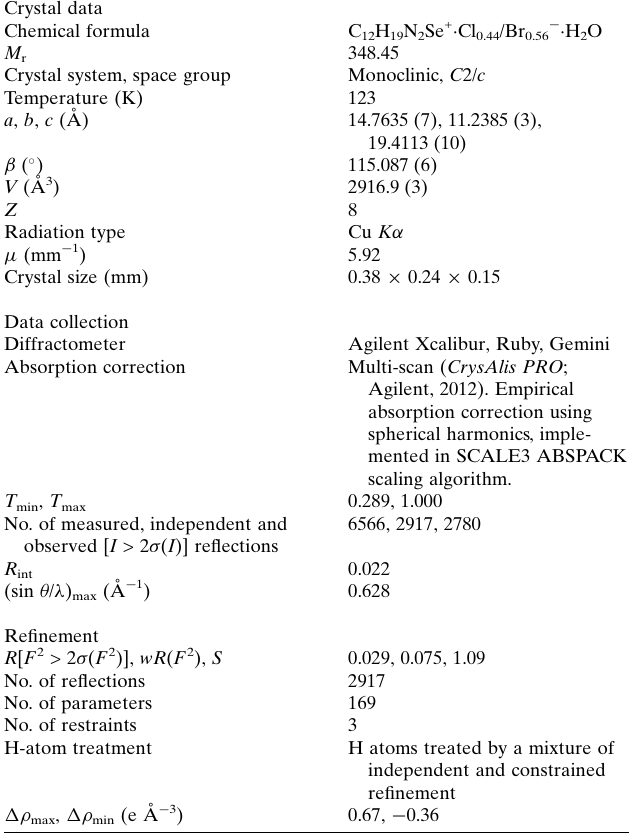
Table 2 Experimental details. Crystal data Chemical